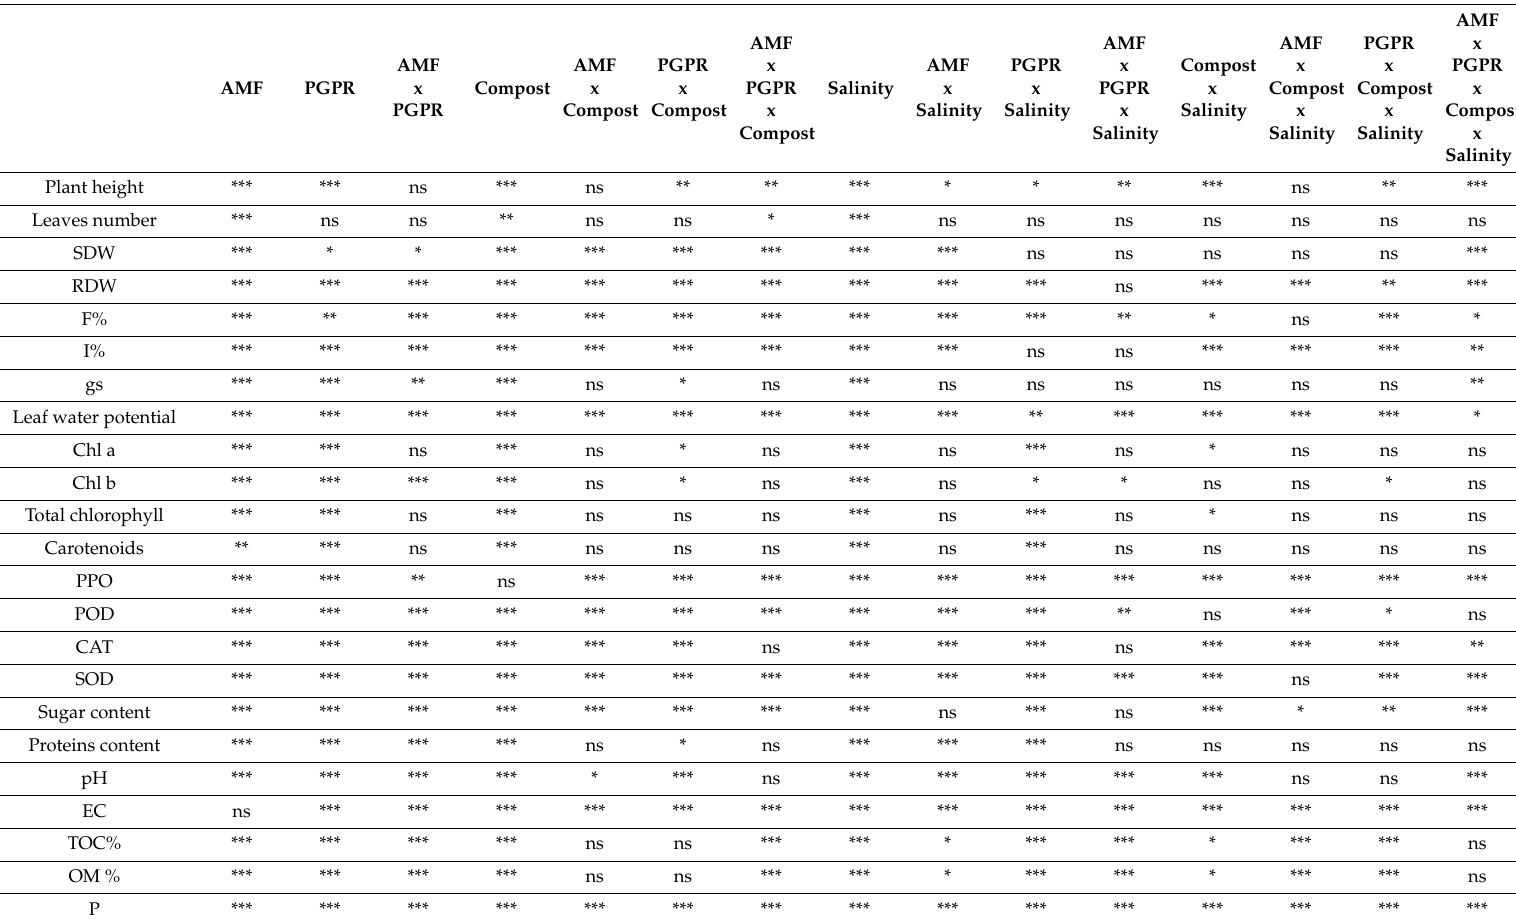
Table 3. Results of a four-way ANOVA test for independent variables, including salinity, PGPR inoculation, AMF inoculation and compost amendment, and interactions among